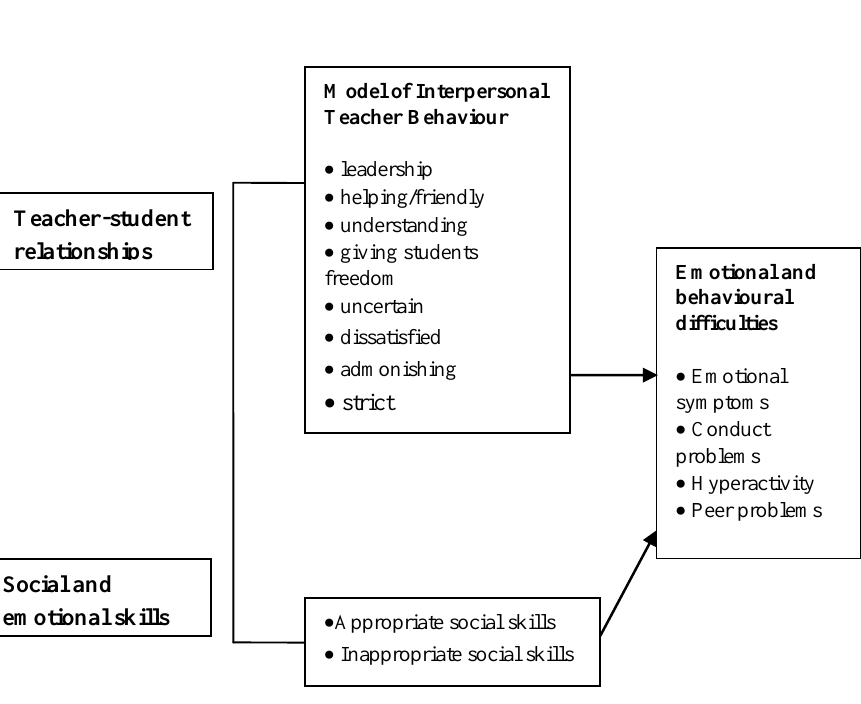
Figure 1. Hypothesized model exploring the relationships between teacher-student relationships and social and emotional skills with emotional and behavioural